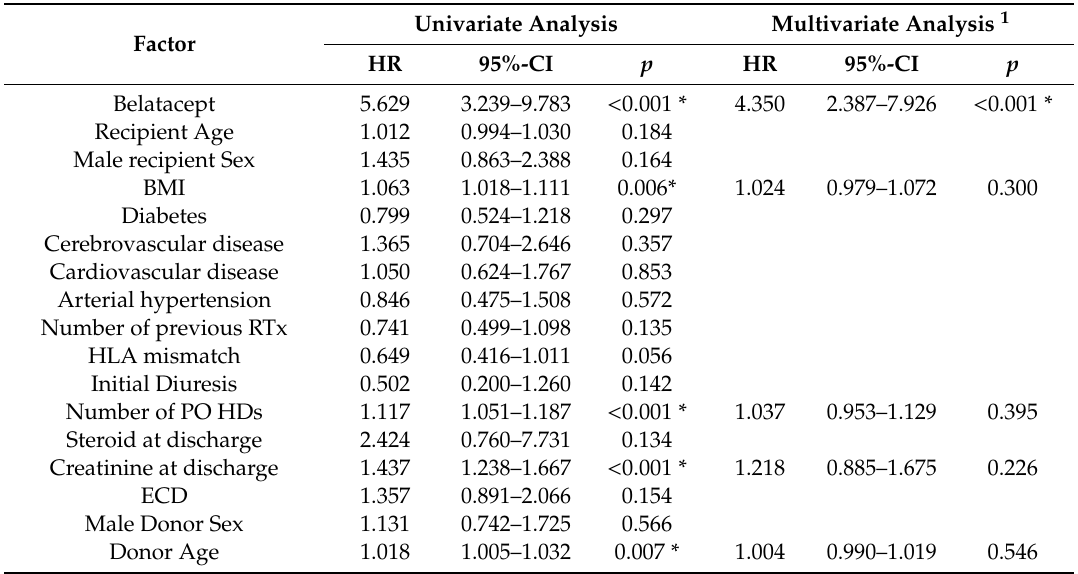
Table 4. Cox regression for eGFR better than the median ( + 0.35 mL / min / 1.73 m 2 / year) at last follow-up. We calculated univariate hazard ratios (HR) for risk factors. All significant univariate risk factors were used in the multivariate model. BMI: body mass index, RTx: renal transplantation, PO HD: postoperative hemodialysis session, ECD: extended criteria donor.